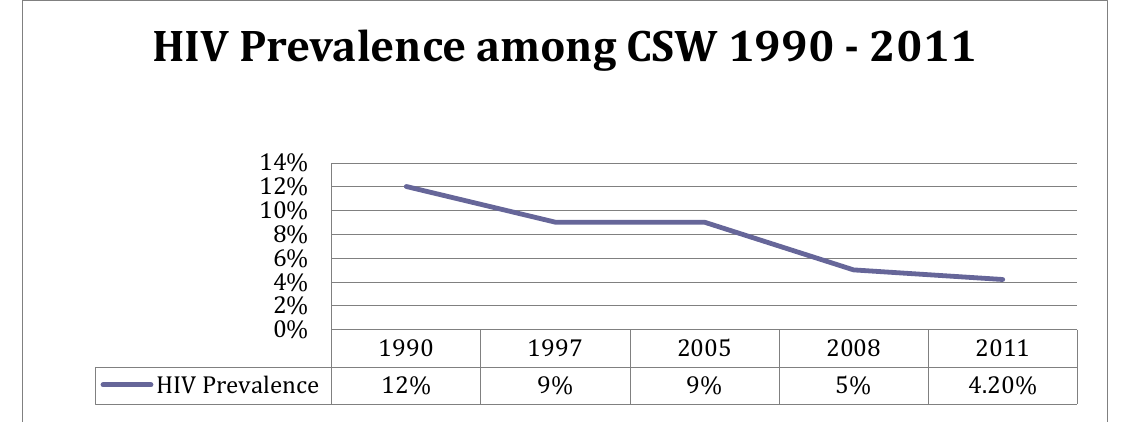
Figure 6: Declining HIV Prevalence among CSW,